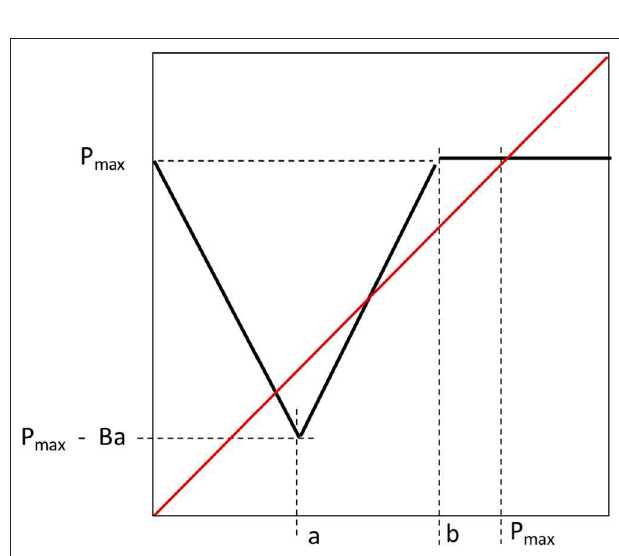
16; A 4.8). (Left) Simple chaotic attractor centered on the lower equilibrium point (b = = 0.32) and the upper point a node. =